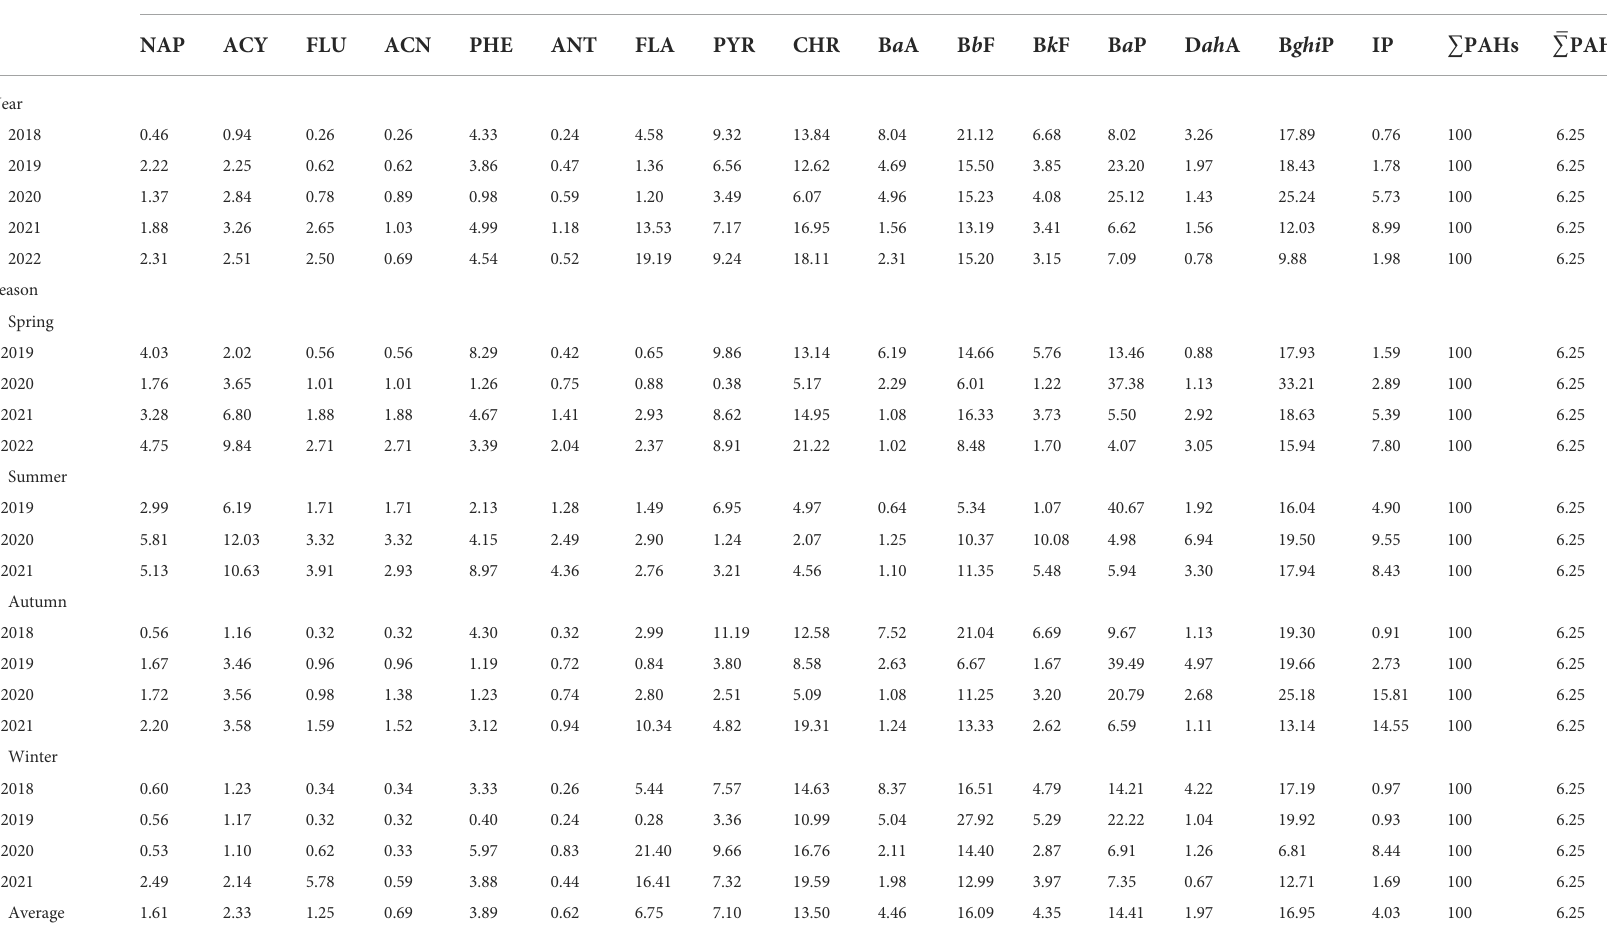
TABLE 4 Percentage of detection rate of 16 PAHs in the study period from 2018 to 2022 (calculated as (cid:6) PAHs accounting for 100%). Year/season PAH